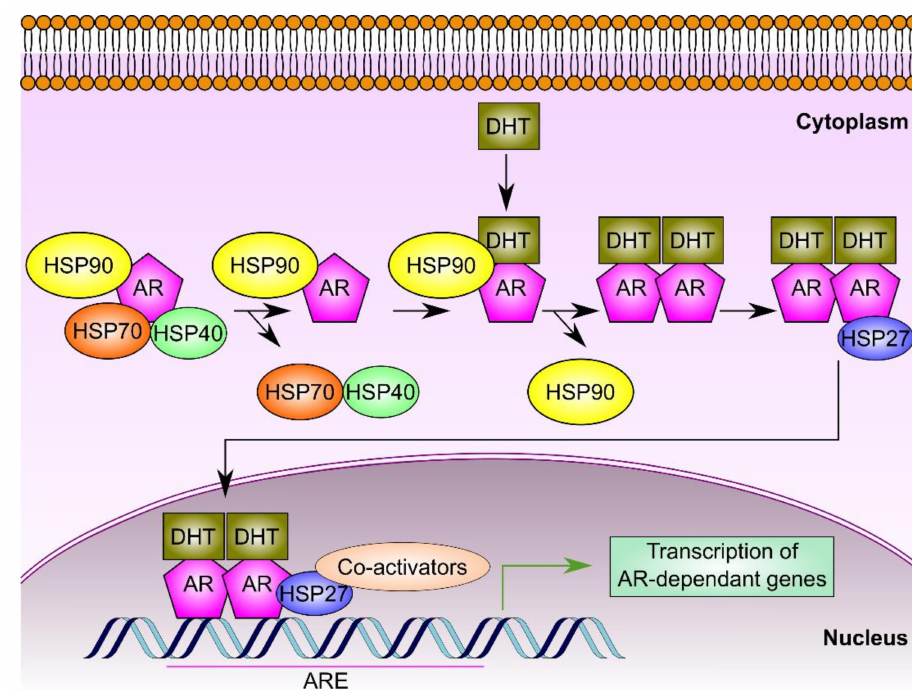
Figure 3. HSPs regulate AR signaling. A complex of chaperones including HSP90 associates with the AR to expedite and maintain its high a ffi nity binding conformation, thus allowing for DHT interaction. As a consequence, the AR forms a dimer and the chaperone complex dissociates. Thereafter, HSP27 binds to the AR homodimer enabling its nuclear translocation, subsequent binding to the ARE, and activation of transcription of AR-dependent